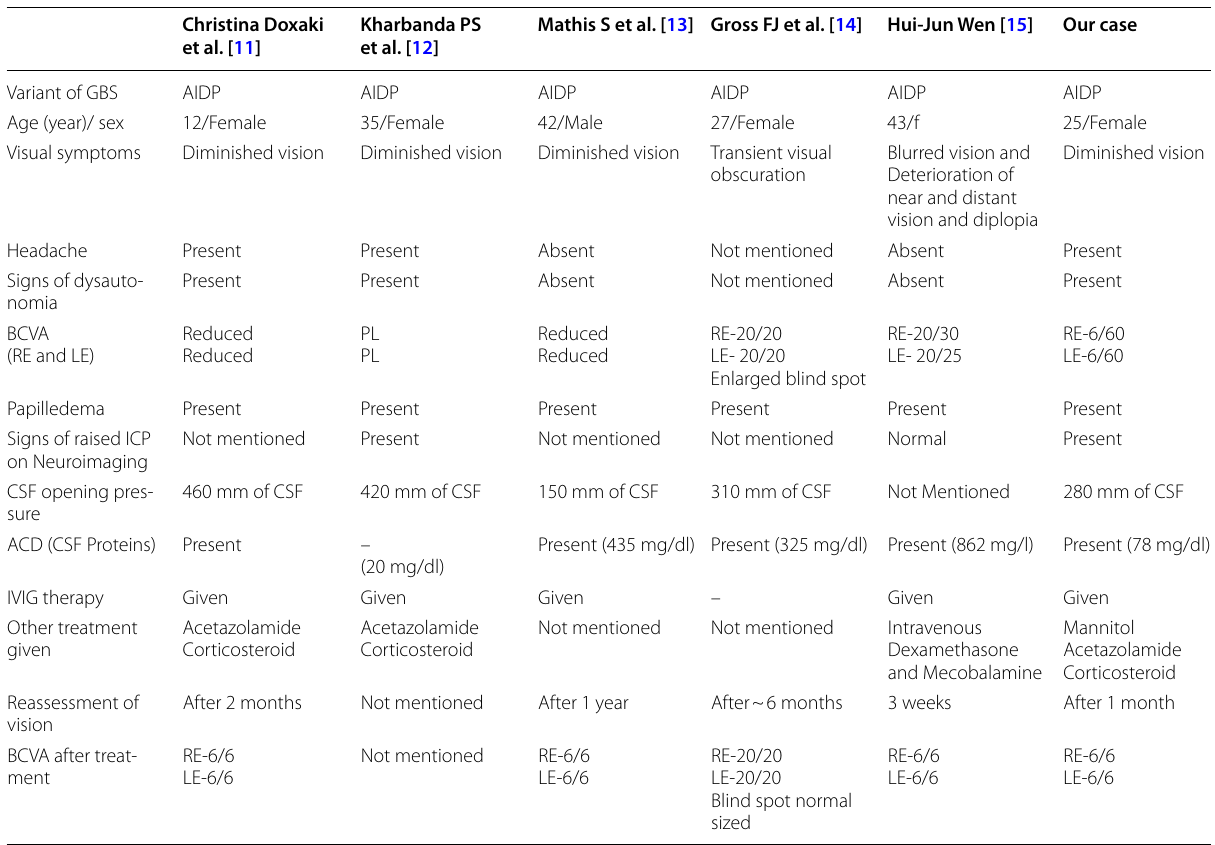
Table 2 Summary of cases reported in literature of GBS with vision loss due to